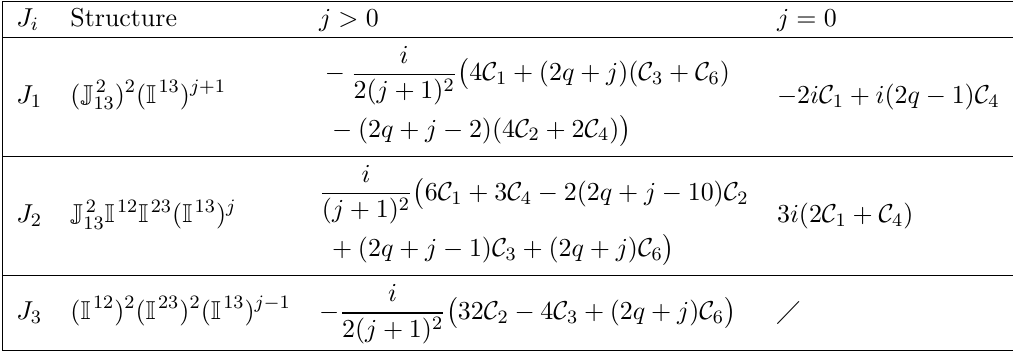
Table 20 . Expansion of the supersymmetric correlator in the component has spin (0 ; 1 ( j +1)) and QO has spin ( 1 2 = C 6